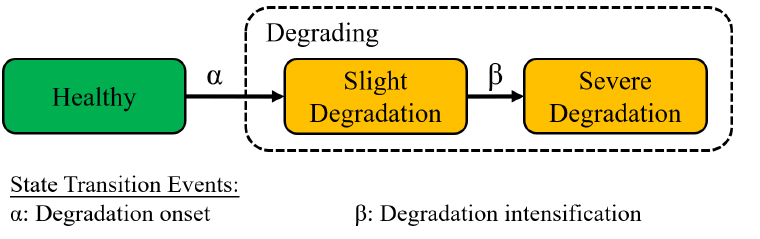
Figure 1. Multi-state health model statechart.